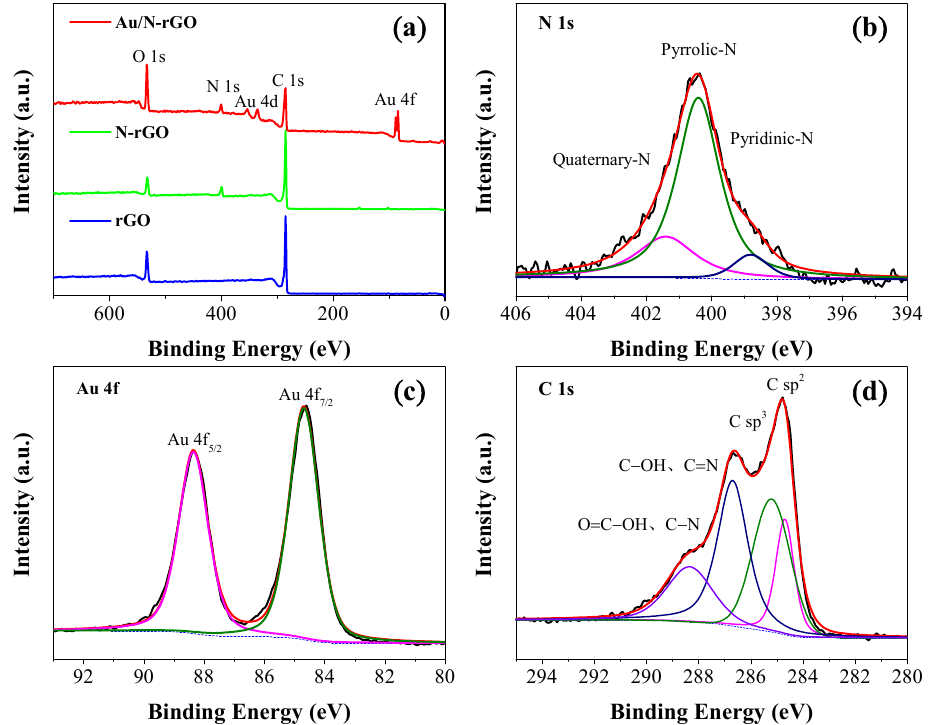
Figure 2. ( a ) X-ray photoelectron spectroscopy (XPS) spectra of as-synthesized Au/N-rGO, N-rGO, and rGO filters. ( b – d ) Correspond, respectively, to the XPS spectra of N, Au, and C elements in the Au/N-rGO filter at an Au/C ratio of 0.2%.